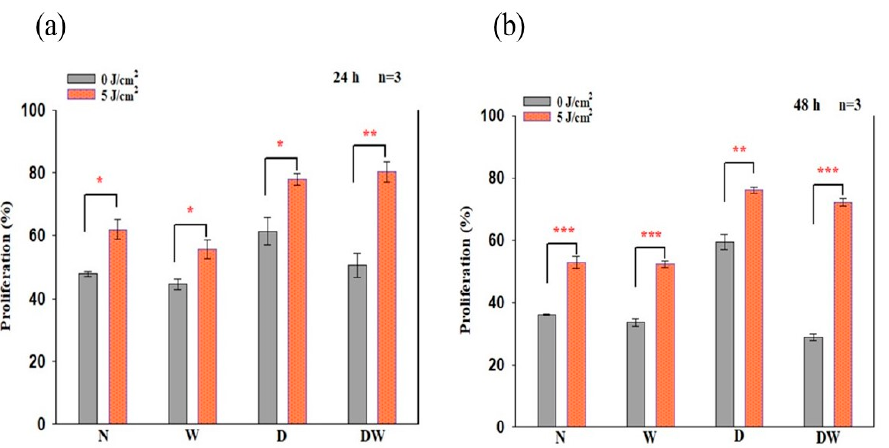
Figure 4. BrdU (5-bromo-2’-deoxyuridine) incorporation (% cellular proliferation) in non-irradiated and irradiated normal (N), wounded (W), diabetic (D), and diabetic wounded (DW) cell models following irradiation at 660 nm, with 5 J/cm 2 at 24 h ( a ) and 48 h ( b ) determined by flow cytometry. Data are expressed as ± SEM (n = 3). Significant probabilities compared to the non-irradiated controls are shown as * p < 0.05 , ** p < 0.01 and *** p < 0.001.